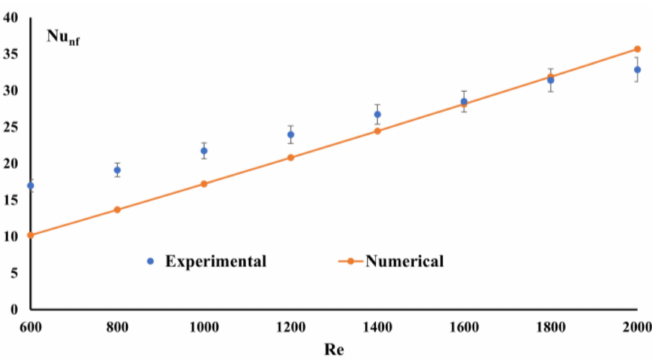
Figure 4. Average nanofluid Nusselt number versus the flow